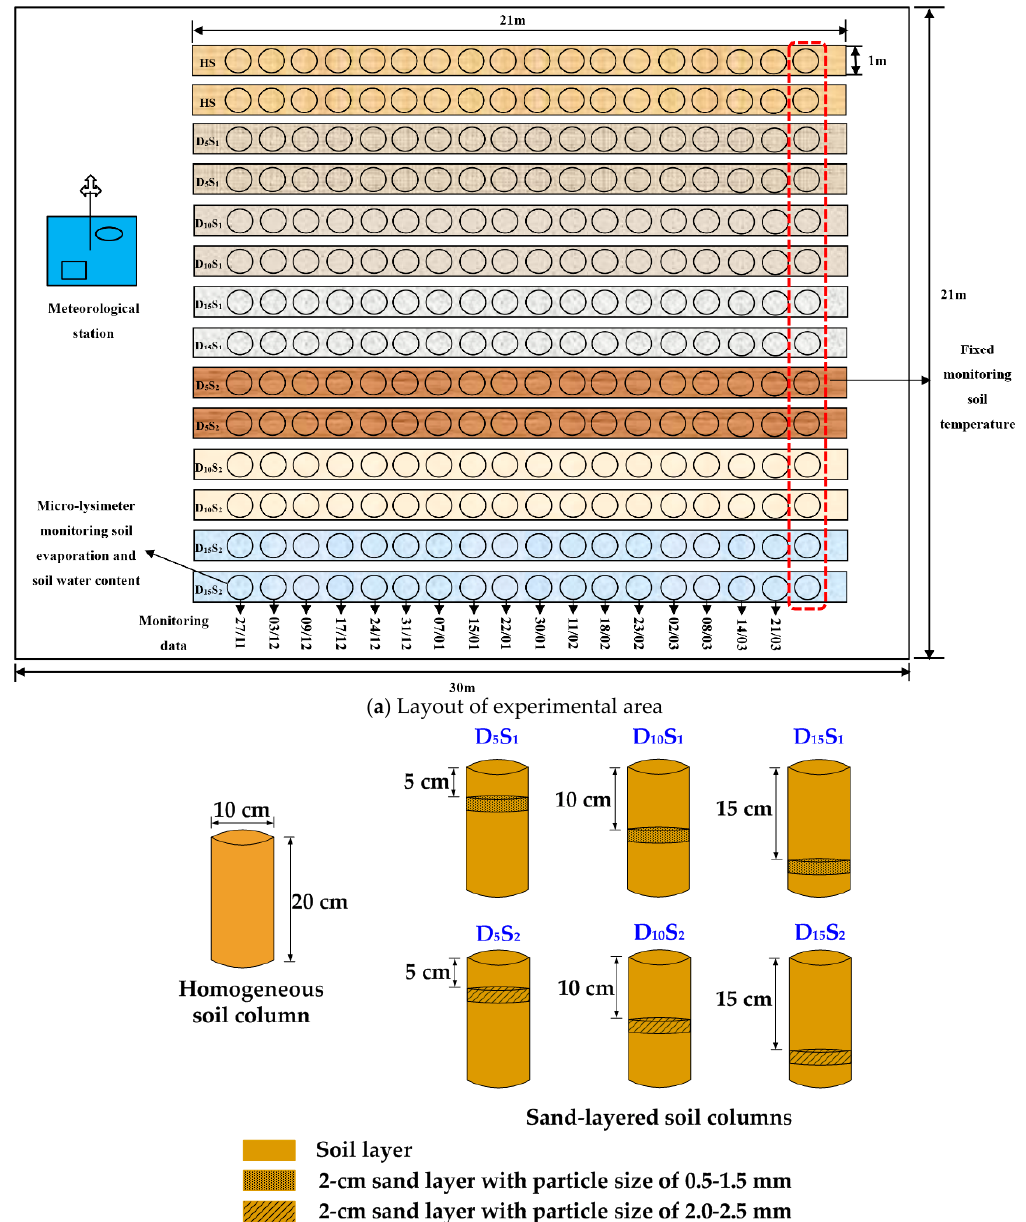
Figure 3. ( a ) Layout of experimental area; and ( b ) micro-lysimeters of the homogeneous soil column and sand-layered soil